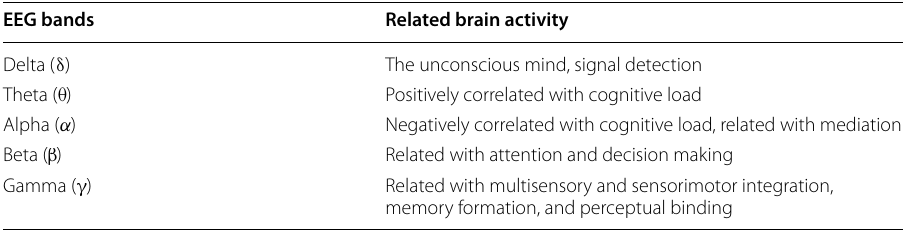
Table 1 Relationships between EEG bands and brain activities EEG bands Related brain activity The unconscious mind, signal detection Positively correlated with cognitive